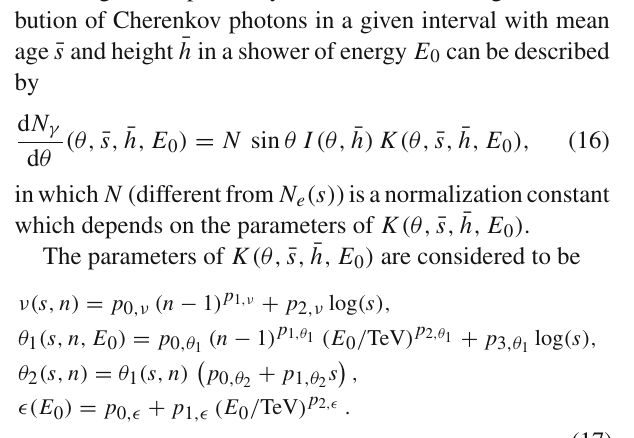
angular distribution of Cherenkov photons of five randomly chosen gamma-ray-induced air showers at different values of s and h are compared. From the cascade theory [31–33], the angular distributions of Cherenkov light in gamma-ray showers are expected to be independent of the primary par- ticle energy and this is confirmed in the bottom-left plot of Fig. 3. In the case of proton showers, some dependency on the primary energy is observed in the bottom-right plot of the same figure. These plots also reiterate the fact that distribu- tions with common age, height, primary type, and primary energy are